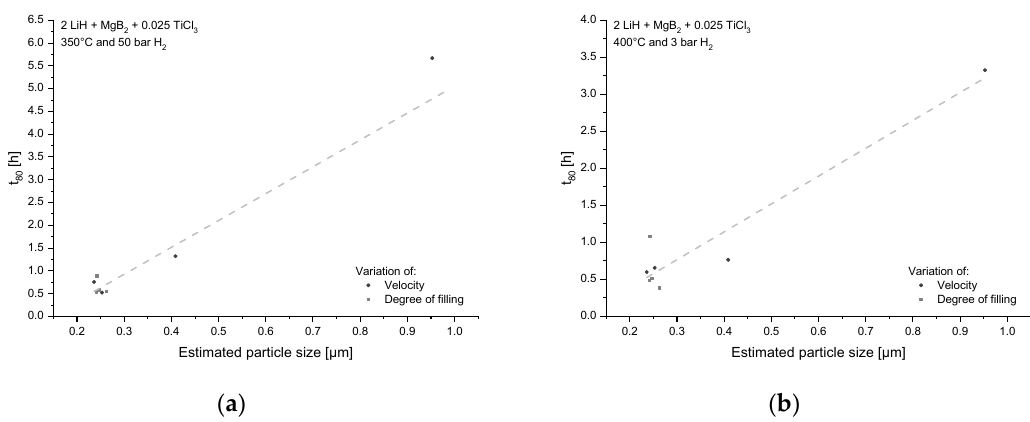
Figure A2. Kinetic behavior as a function of calculated particle size after grinding for ( a ) absorption and ( b ) desorption.